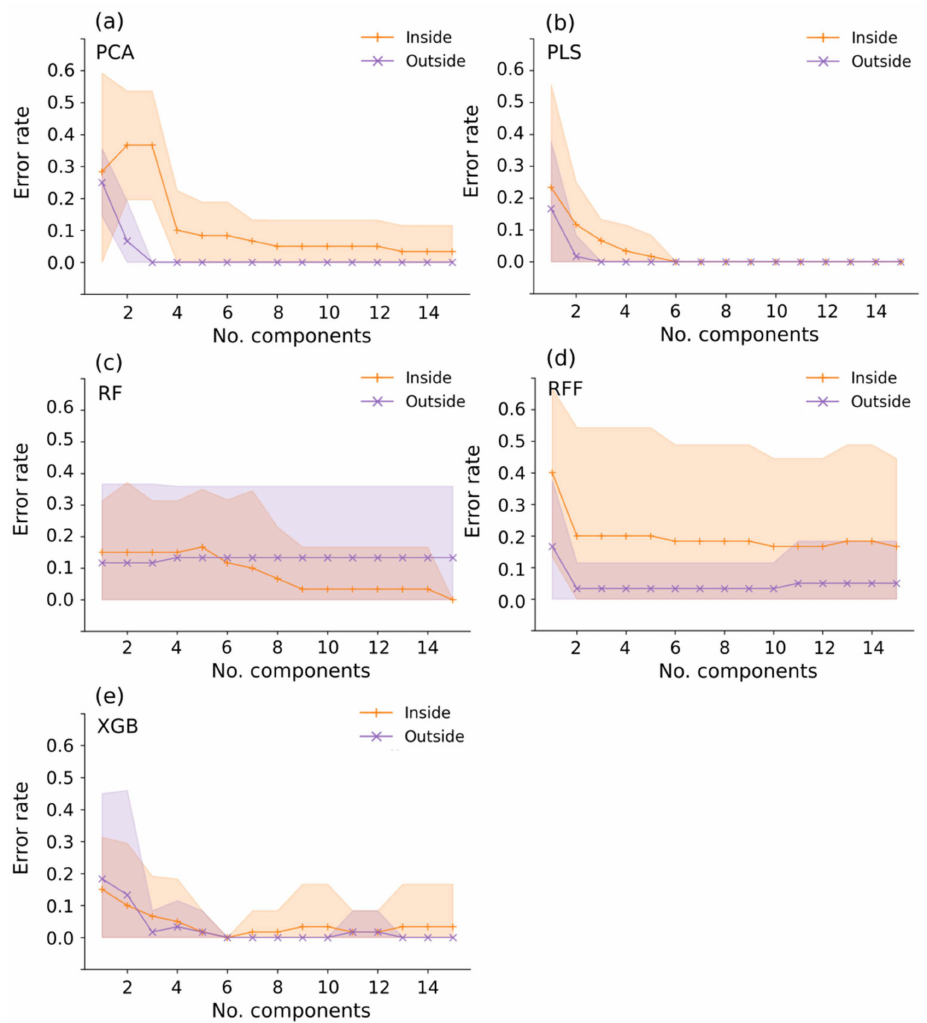
Figure 7. Influence of increasing number of features on classification error rates for both inside and outside tuber data. Since LDA generates only one feature in binary classification it wasn’t included in this figure. ( a ) Principal component analysis, ( b ) Partial least squares, ( c ) Random forest, ( d ) ReliefF, and ( e ) Extreme gradient